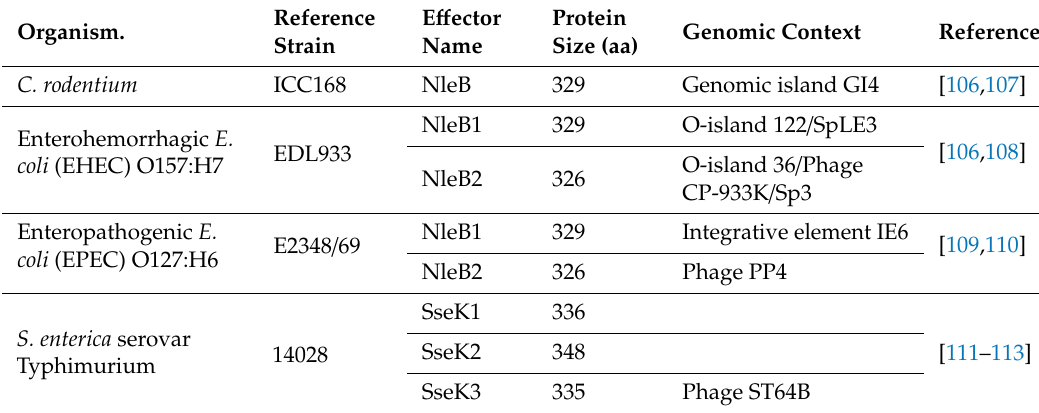
Table 2. NleB / SseK glycosyltransferases.